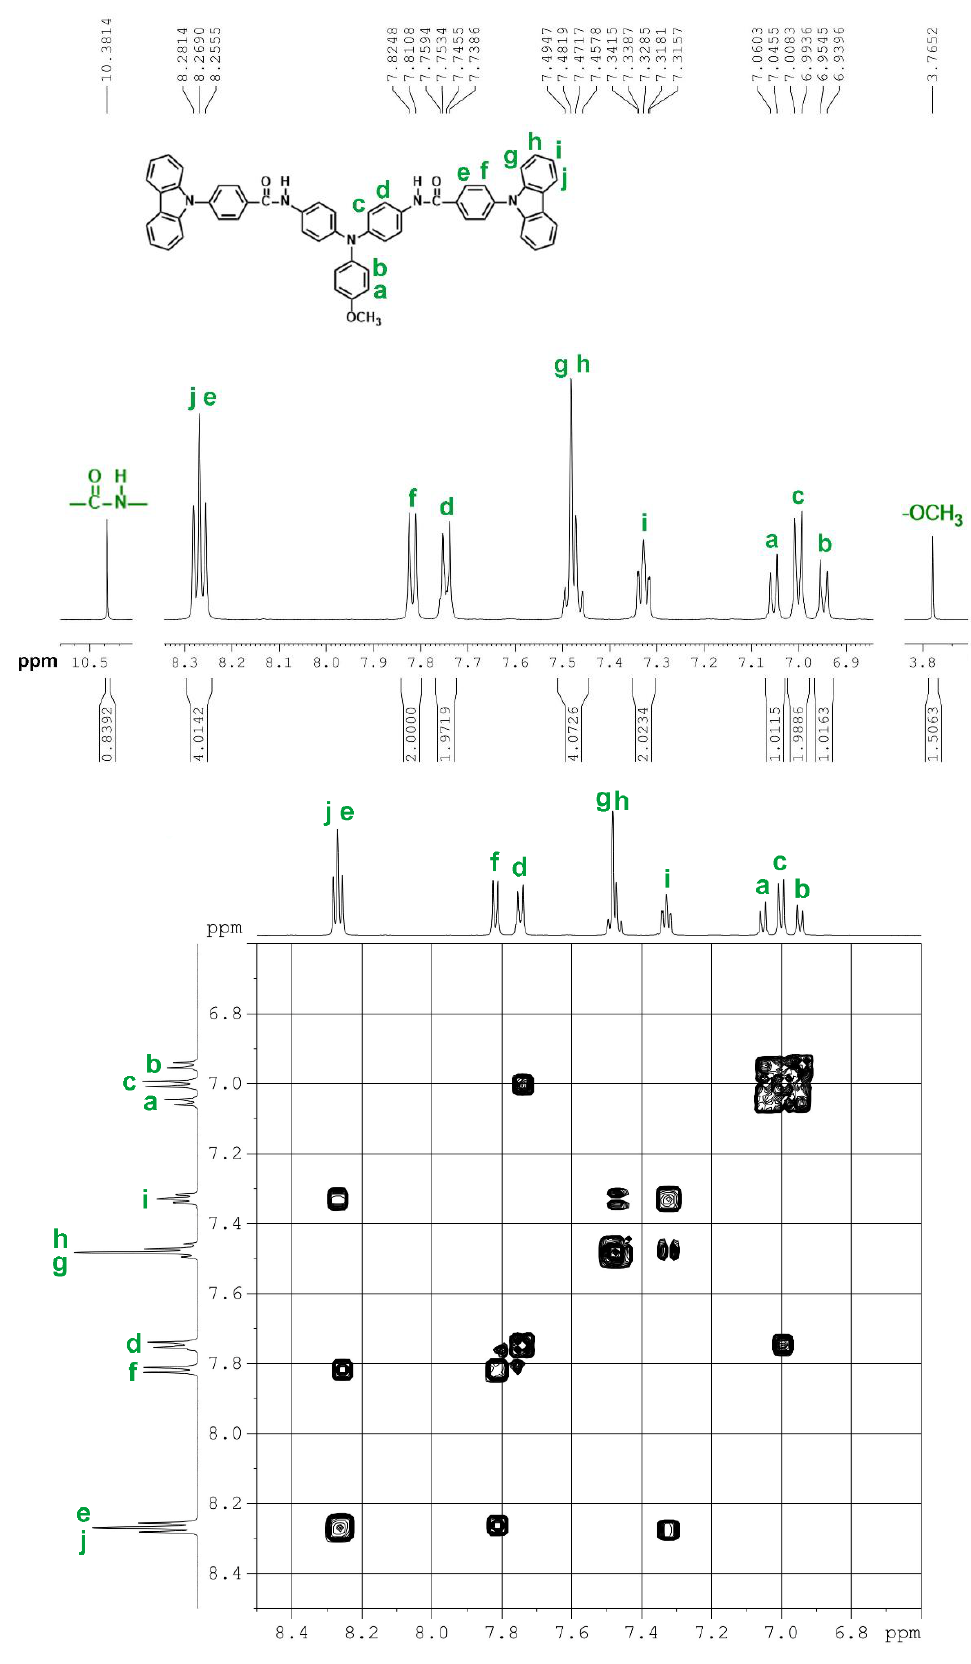
Figure 2. 1 H NMR and H-H COSY spectra of MeOTPA-(NPC) 2 in DMSO- d 6 .